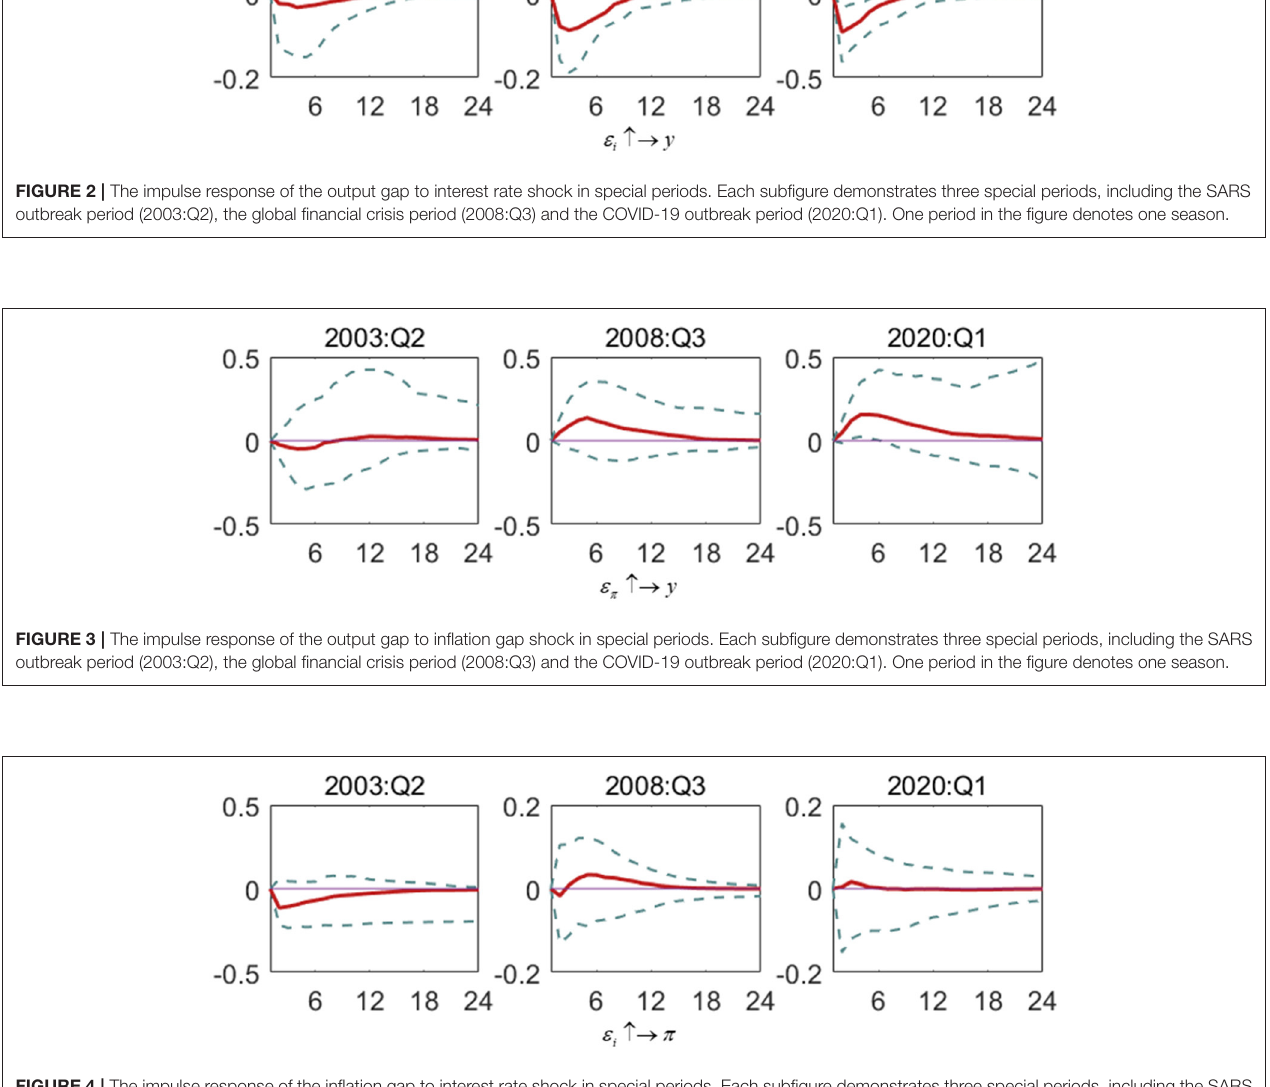
FIGURE 4 | The impulse response of the inflation gap to interest rate shock in special periods. Each subfigure demonstrates three special periods, including the SARS outbreak period (2003:Q2), the global financial crisis period (2008:Q3) and the COVID-19 outbreak period (2020:Q1 ). One period in the figure denotes one